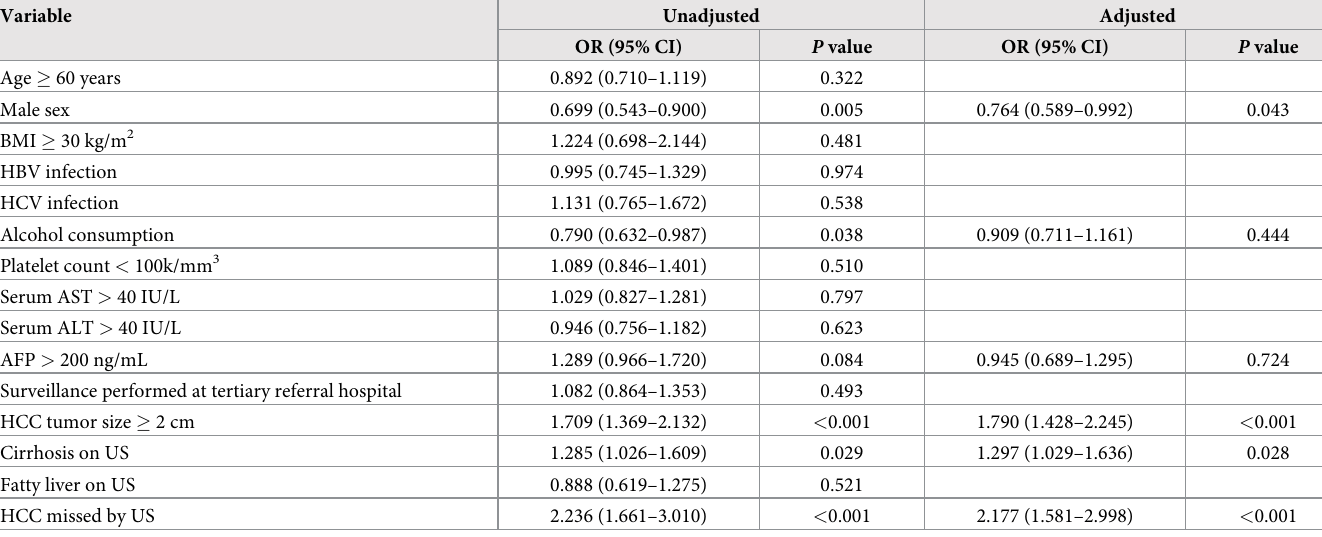
Table 3. Baseline parameters related to detection of hepatocellular carcinoma tumors located within blind spots during surveillance.